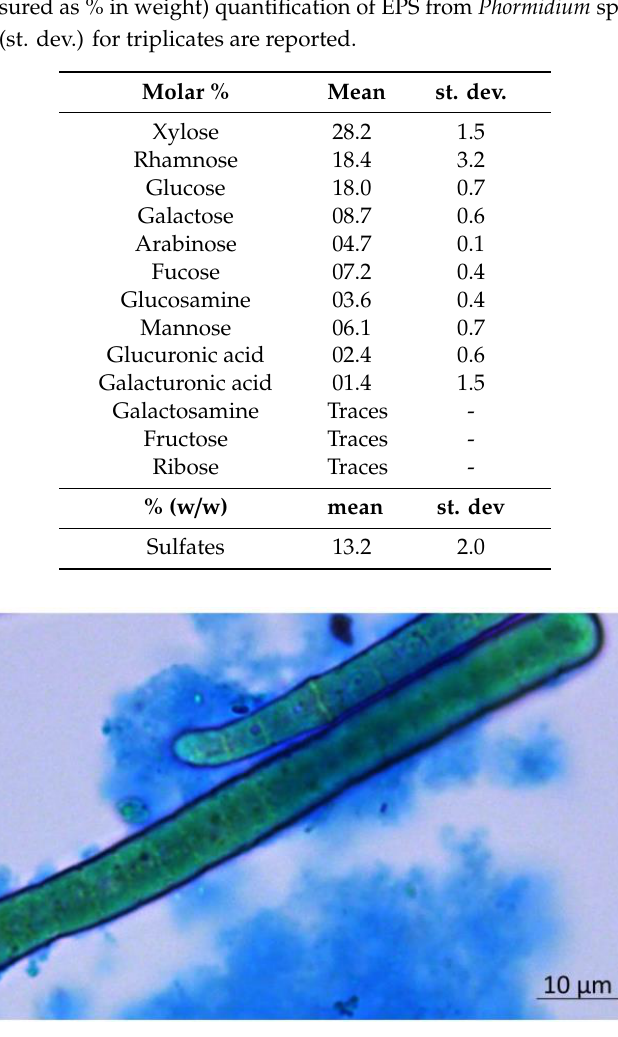
Figure 1. Visualization of Phormidium EPS through the bright-field image of Alcian-blue-stained culture. 3.2. Phormidium EPS Treatment Does Not Interfere with In Vitro Cell Viability of Human Skin Fibroblast